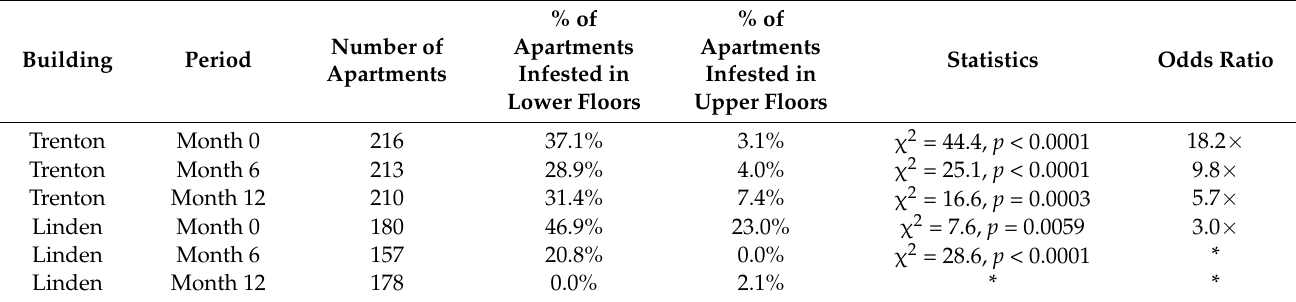
Table 3. Distribution of mouse activity between the lower three floors and floors four and